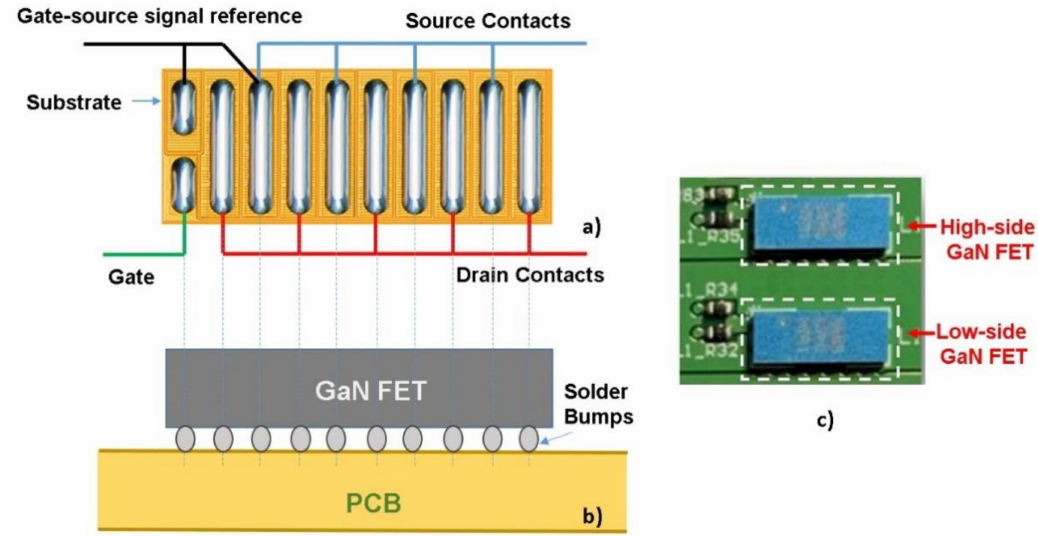
Figure 3. ( a ) Solderable bars package solution with connection of the source, drain, gate and substrate contacts. ( b ) Package and PCB assembly. ( c ) Photo of a top-layer of the PCB with a discrete device in the CSP solution for a half-bridge